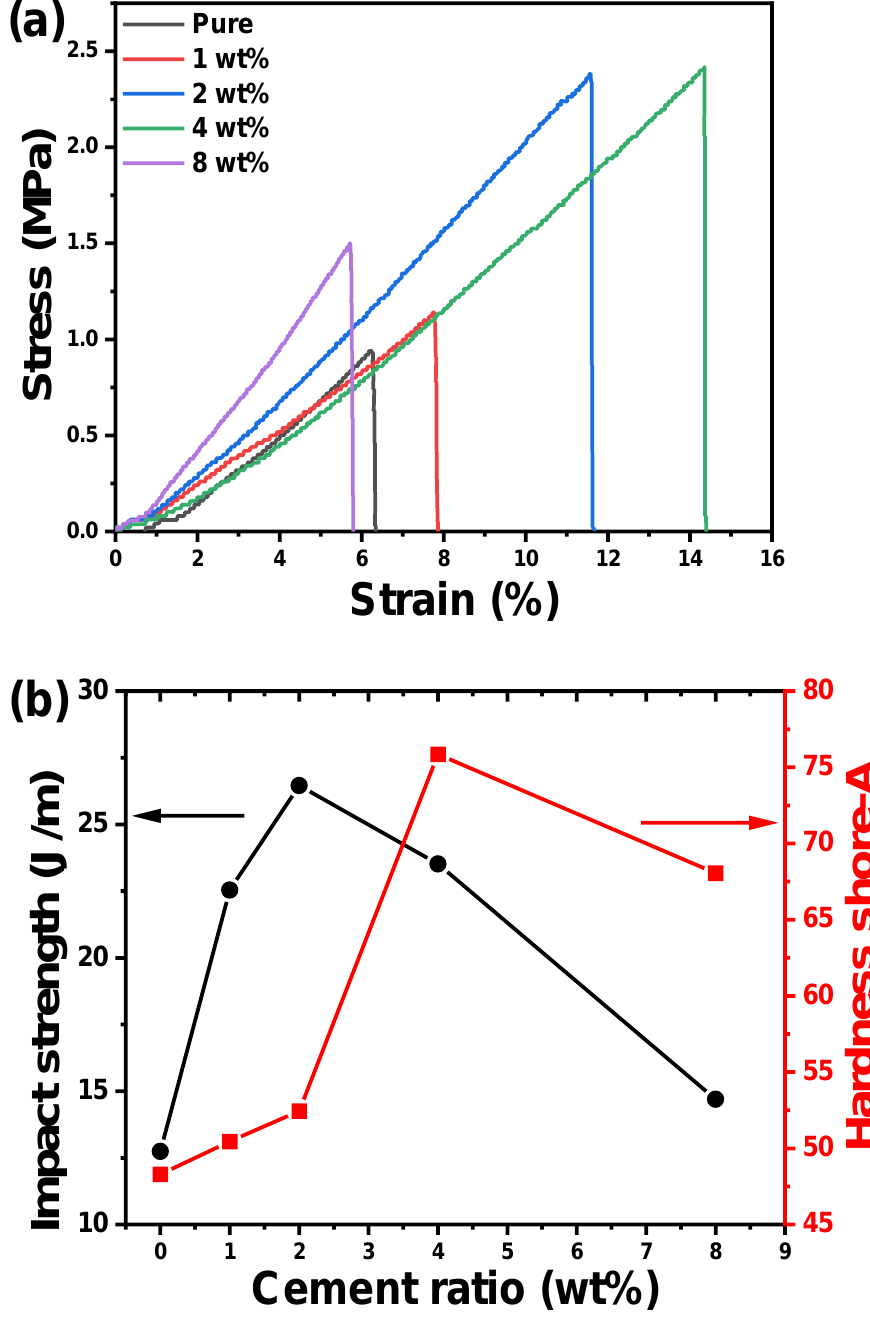
Figure 7. ( a ) The average flexural stress-strain curves, ( b ) impact strength (left-hand side), and hardness shore-A (right-hand side) for acrylic polymer/cement nanocomposites. The impact strength and hardness shore-A of pure acrylic polymer and acrylic poly- mer/cement nanocomposites are shown in Figure 7b. Both the impact strength and hard- ness of shore-A increase as the cement ratio increases, and then decrease as the cement ratio increases further. The maximum impact strength value was found in acrylic